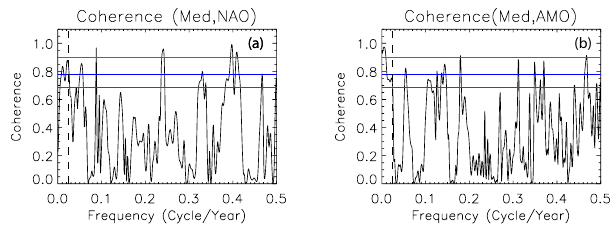
Fig. 18. Magnitude squared coherence estimation between (a) Mediterranean SST and NAO, and (b) Mediterranean SST and AMO. Green, blue, and yellow lines represent the 90%, 95%, and 99% confidence limits, respectively (modified from Marullo et al., 2011, American Meteorological Society; used with